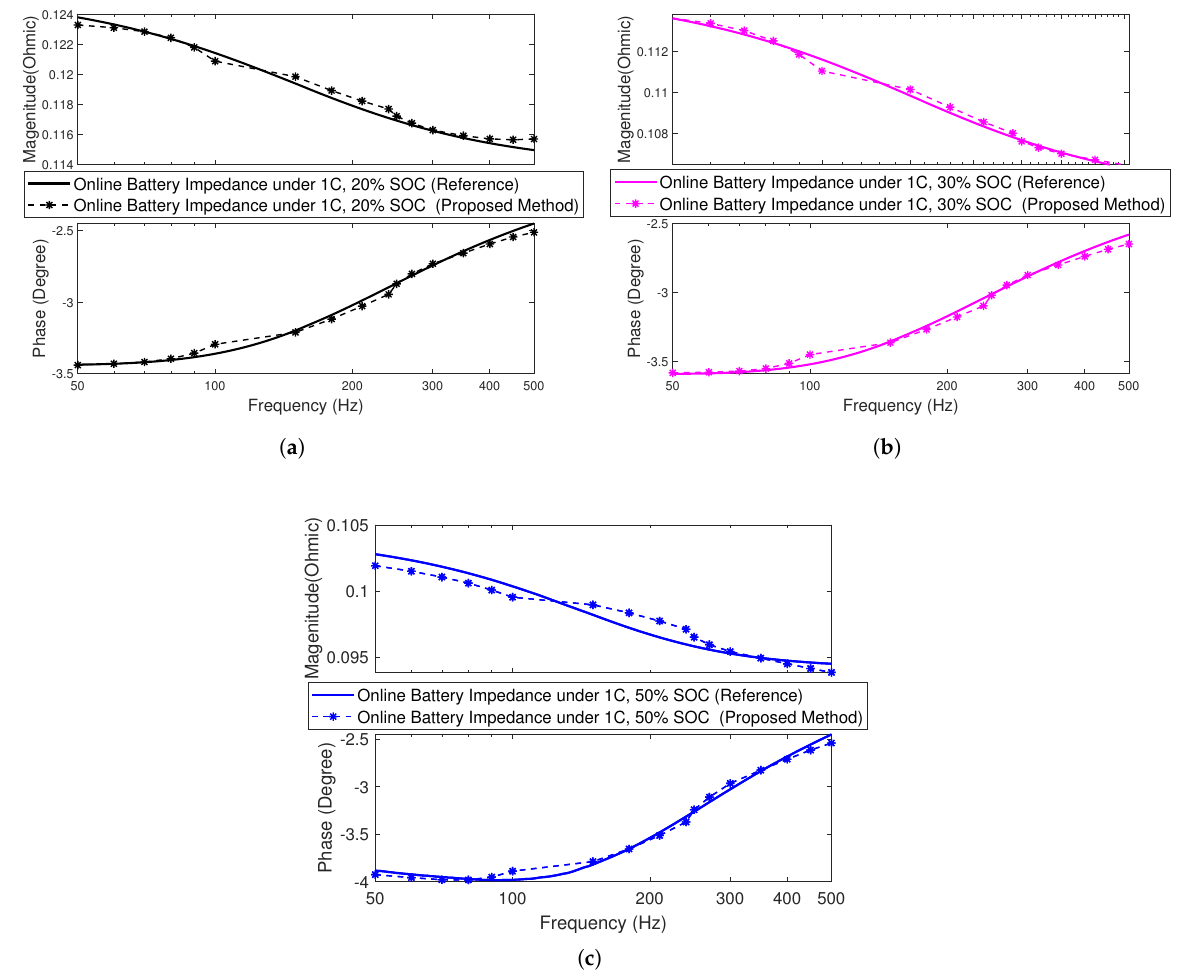
Figure 8. Online battery impedance results (50 Hz to 500 Hz) under different SOC values ( a ) under 1C, 20% SOC ( b ), under 1C, 30% SOC, and ( c ) under 1C, 50%